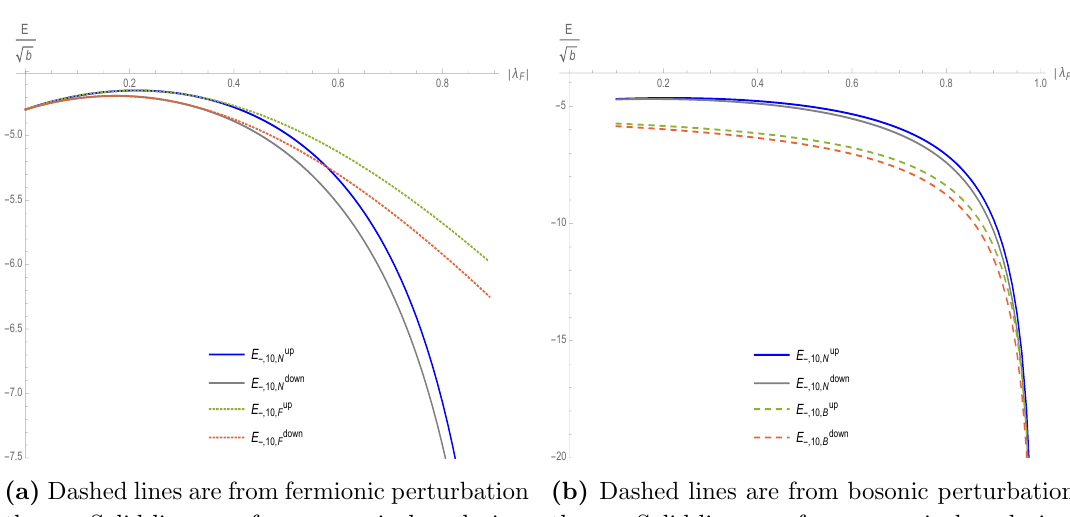
(b) Dashed lines are from bosonic perturbation theory. Solid lines are from numerical analysis. p = (cid:0) j b j . B